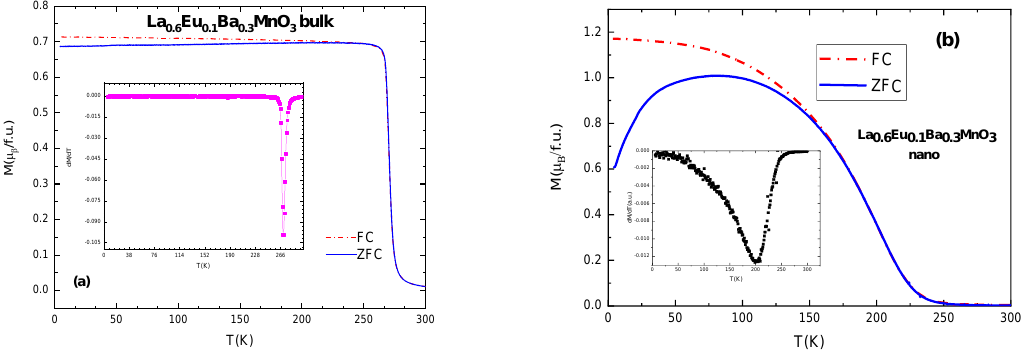
Figure 6. ( a ) ZFC-FC curves and derivative of magnetization (in inset) for the bulk sample with x = 0.1; ( b ) ZFC-FC curves and derivative (in inset) for nanocrystalline sample with x = 0.1. Arrott plots ( M 2 vs. H / M ) allow the determination of the magnetic phase transition Nano-scale particles also show ferromagnetic behavior, but their T C values are lower order [32]. According to the Banerjee criterion, positive and negative slopes of the curves compared to the equivalent bulk material, as shown in Figure 6. This is due to the size of correspond to second- and first-order magnetic phase transitions, respectively [28]. All of the samples exhibit positive slopes for these curves, indicating second-order magnetic phase transitions. A selected sample of Arrott plots are presented in Figure 7.